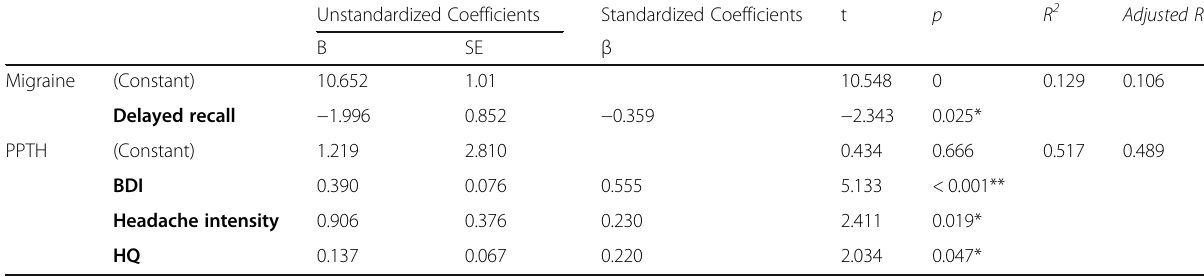
Table 4 Multiple stepwise linear regression analysis for association of insomnia severity scores Unstandardized Coefficients Standardized